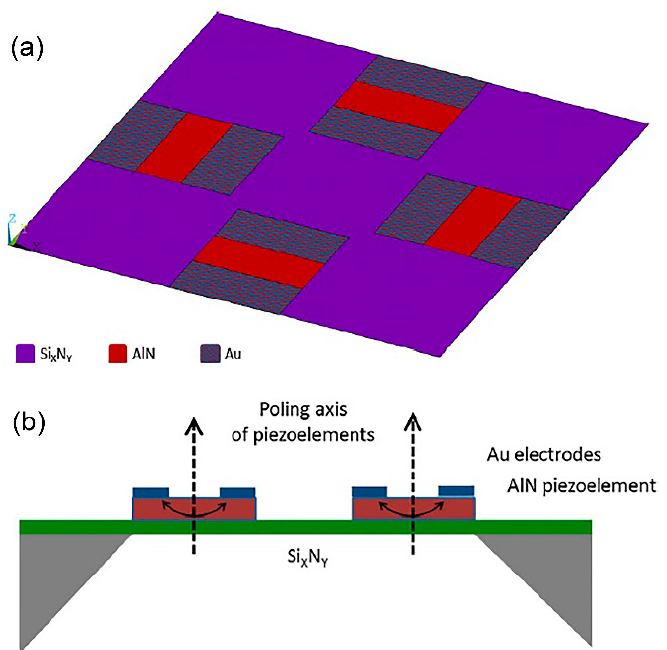
Figure 27. ( a ) Si x N y membrane of dimension 0.5 mm × 0.5 mm with four AlN/Au piezoelectric elements. ( b ) The cross-section schematic of device showing AlN and gold electrodes operating in mode 33. Reprinted from [43], Copyright (2015), with permission from Elsevier.